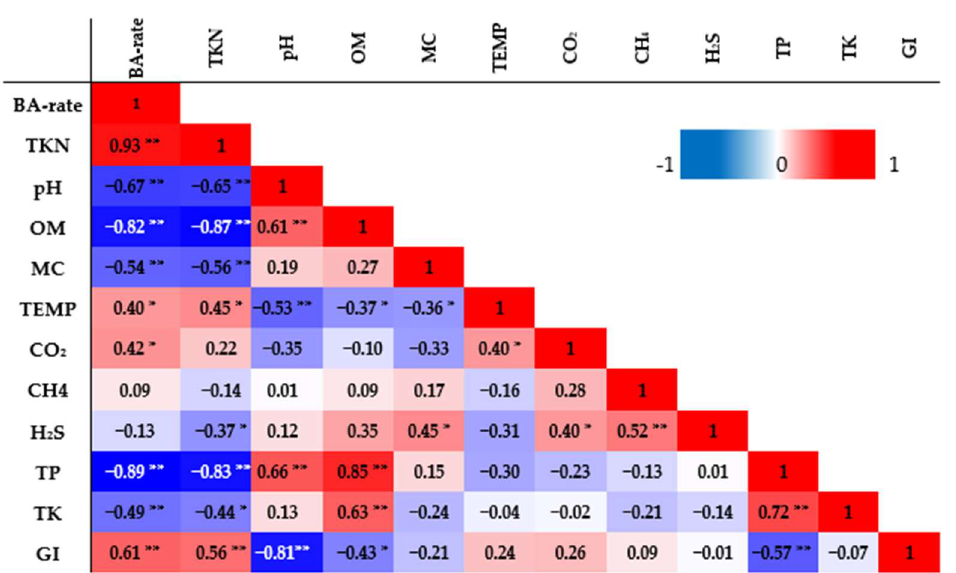
Figure 5. Correlation heatmap from composting parameters, nutrient characteristics, and stability with increasing incorporation rate of inorganic porous BA incorporation to SS. Correlation value ranges between 0 to ±0.35 specified weak, ±0.36 to ±0.47 indicated moderated, and ±0.48 to ±1.0 represented strong positive/ negative correlation. * p < 0.05; ** p < 0.01.